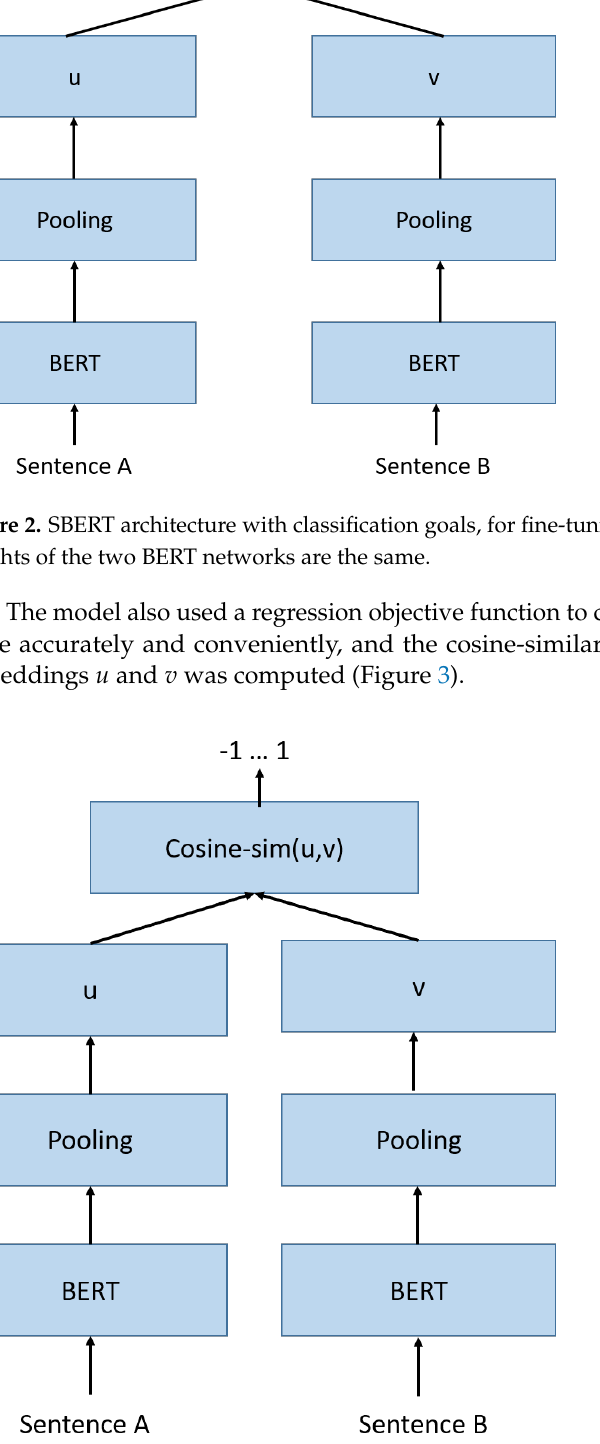
Figure 3. The architecture used by SBERT to calculate similarity scores; this architecture can also be used with the objective function of the